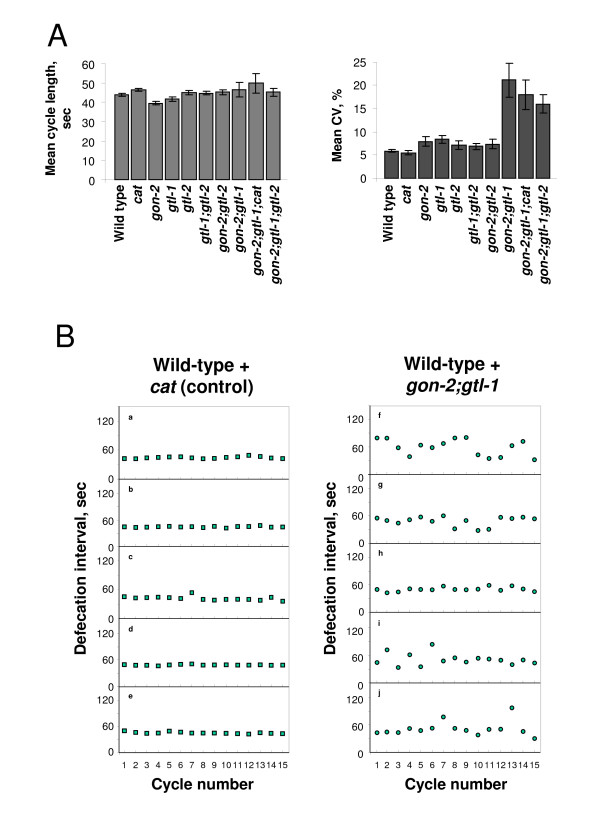
Ablation of gon-2 and gtl-1 by RNAi increases the variability of the defecation cycle. Members of the C. elegans TRPM channel gene family were knocked down using RNAi. When gon-2 and gtl-1 are ablated together the variability (C.V.) but not the period is altered. A: The mean period for each population of worms and the mean coefficient of variation (C.V.). Error bars are SEM. B: The period of 15 consecutive defecation cycles for representative controls (a-e) and gon-2(RNAi);gtl-1(RNAi) (f-j) worms.